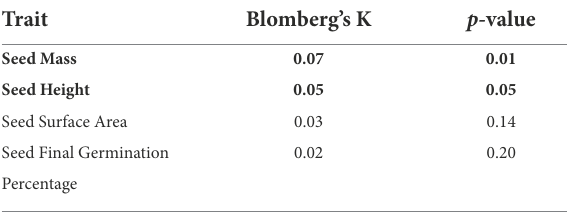
TABLE 2 Phylogenetic signal was tested in seed morphological traits and overall seed final germination